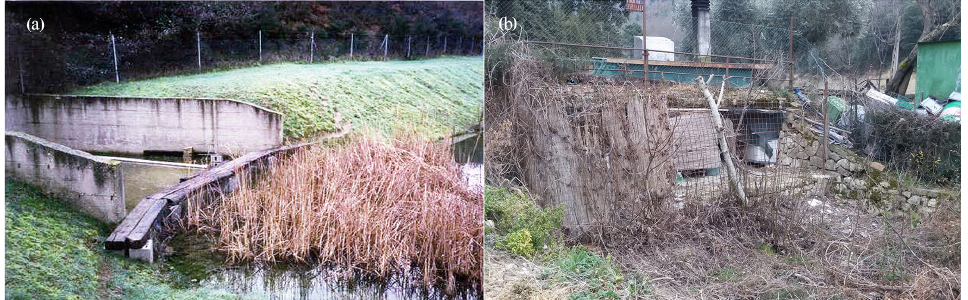
Figure 3. Surface spillway maintenance status: partially efficient (a) , completely obstructed (b) .